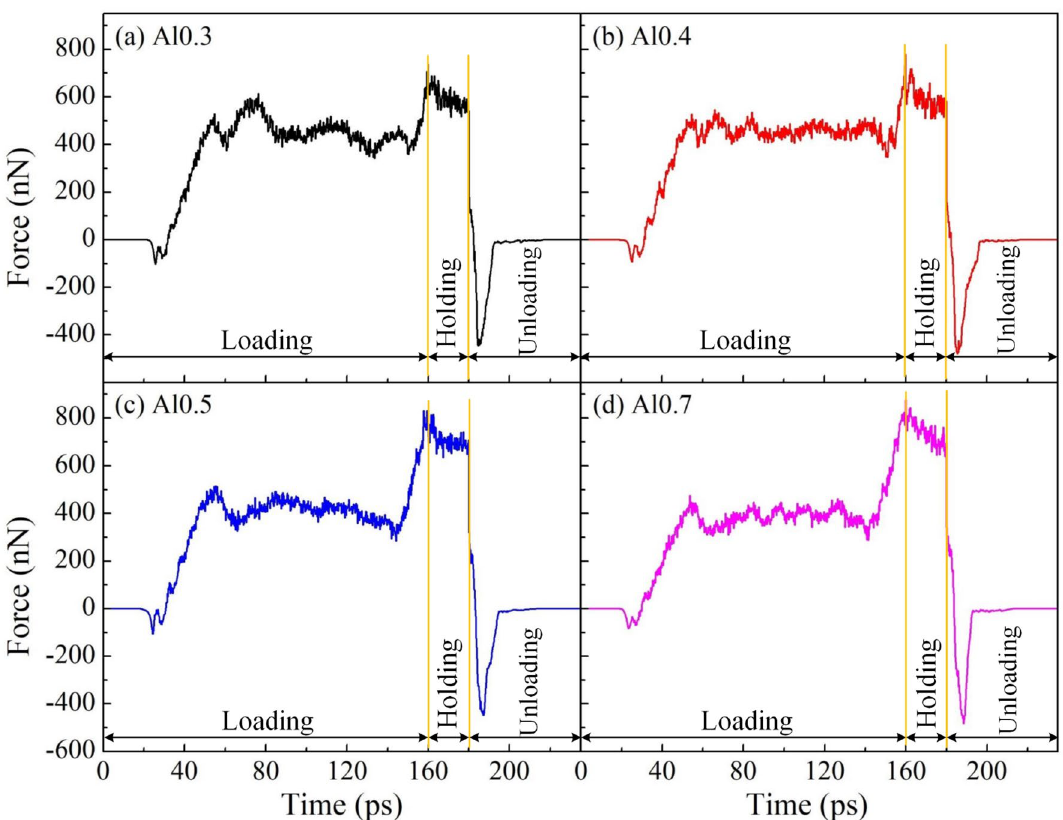
Figure 8. The force–time diagrams for polycrystalline specimens during the nanoimprinting process with various alloy compositions: Al0.3 ( a ); Al0.4 ( b ); Al0.5 ( c ); and Al0.7 ( d ).